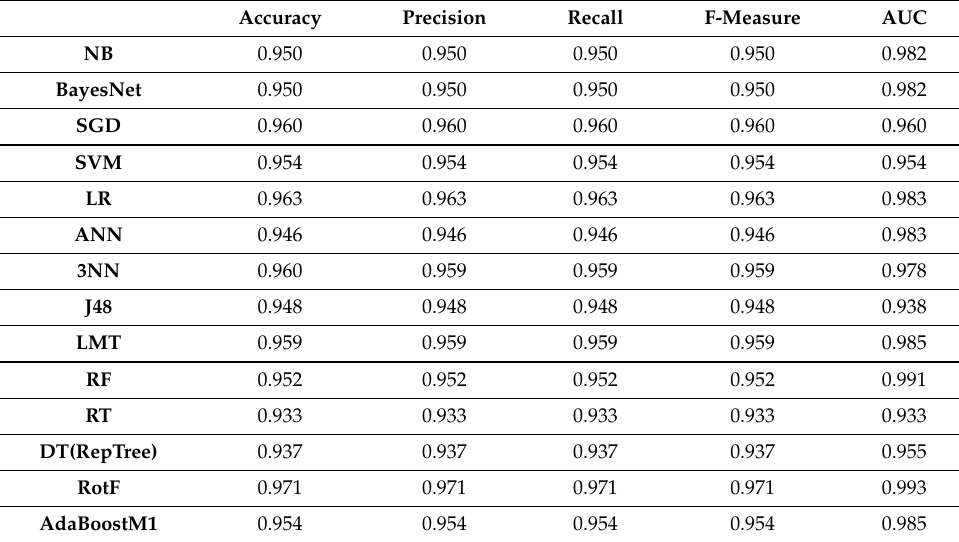
Table 4. Performance evaluation after SMOTE with 10-fold cross validation. Accuracy